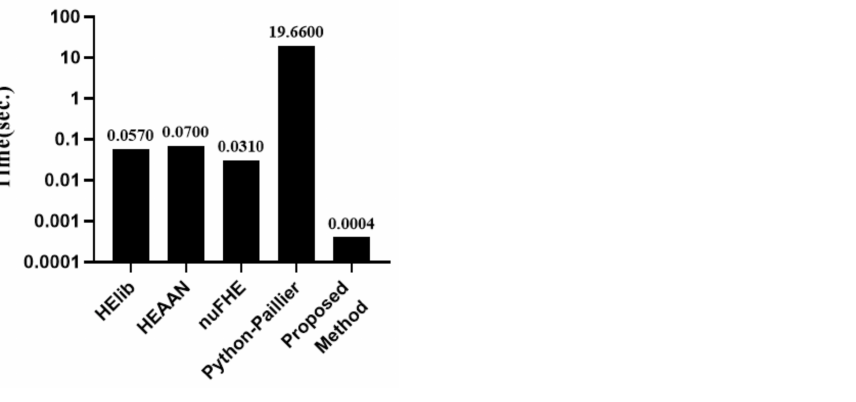
Figure 12. Performance comparison on decrypting the result ciphertext for a search query